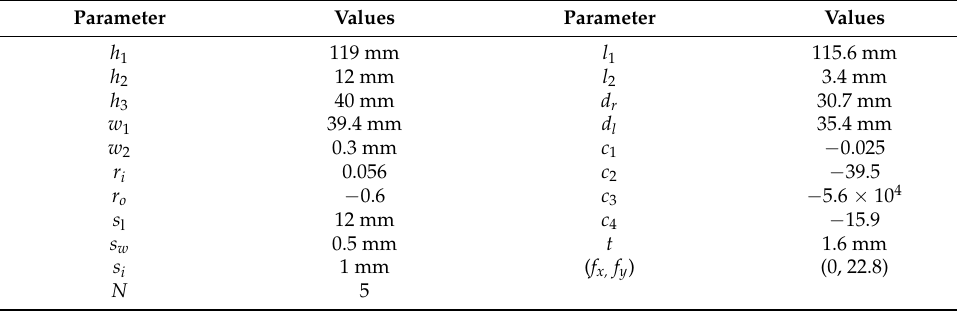
Figure 2. Parametric studies on the rectangular slots and the parasitic loop: ( a ) reflection coefficients according to the antenna sensor components; ( b ) fractional bandwidth according to the parasitic loop structure; ( c ) reflection coefficients according to h 3 ; ( d ) reflection coefficients according to N . Table 1. Values of the proposed antenna.